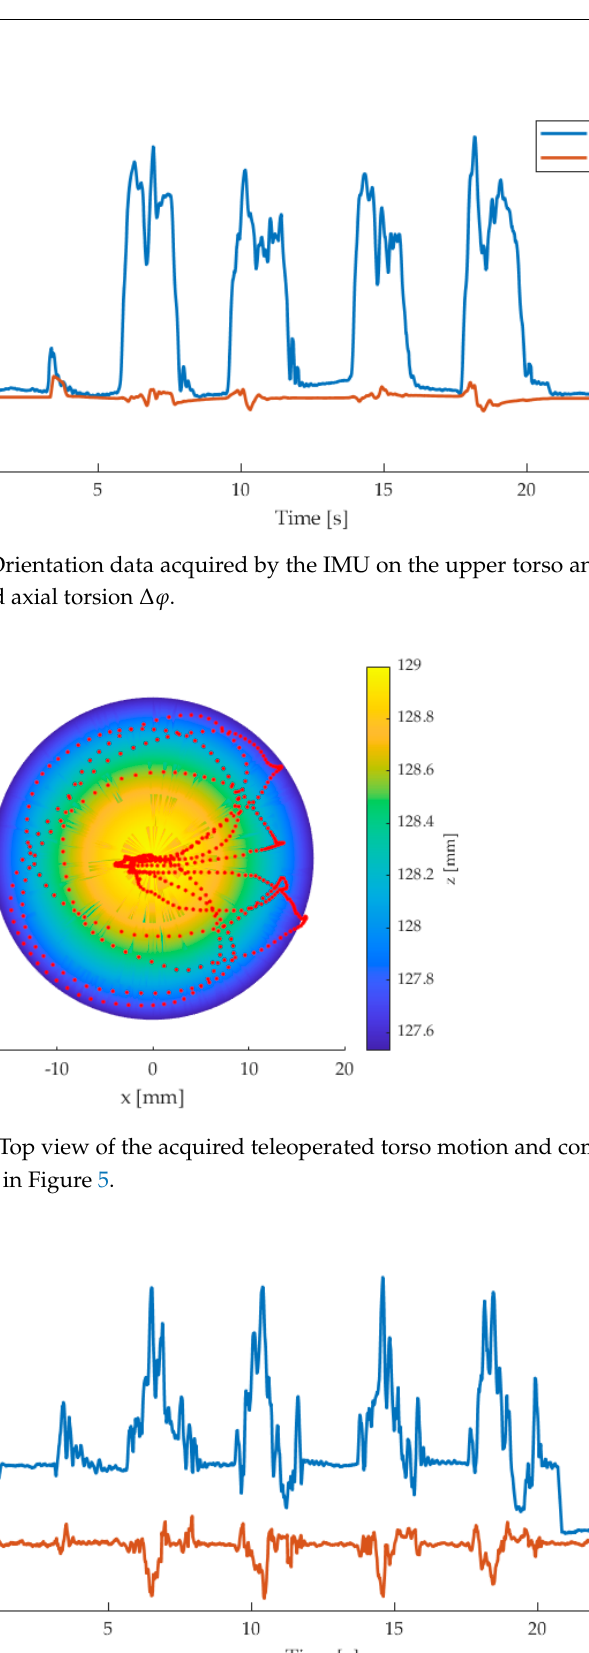
Figure 12. Power consumption acquired with a current sensor during the torso motion reported in Figures 8 and 9.